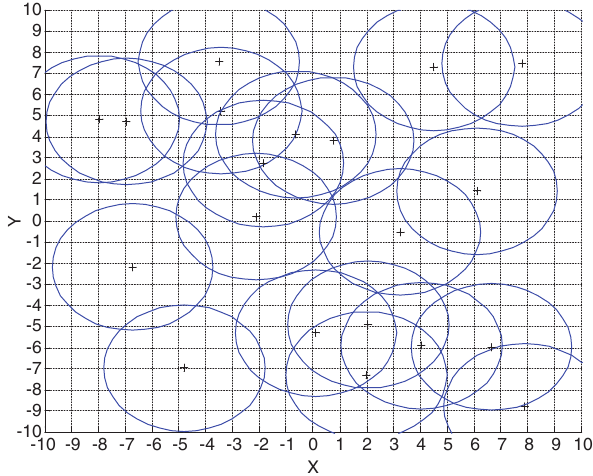
Figure 13: The Node Layout When the Raster Size Was 1*1.